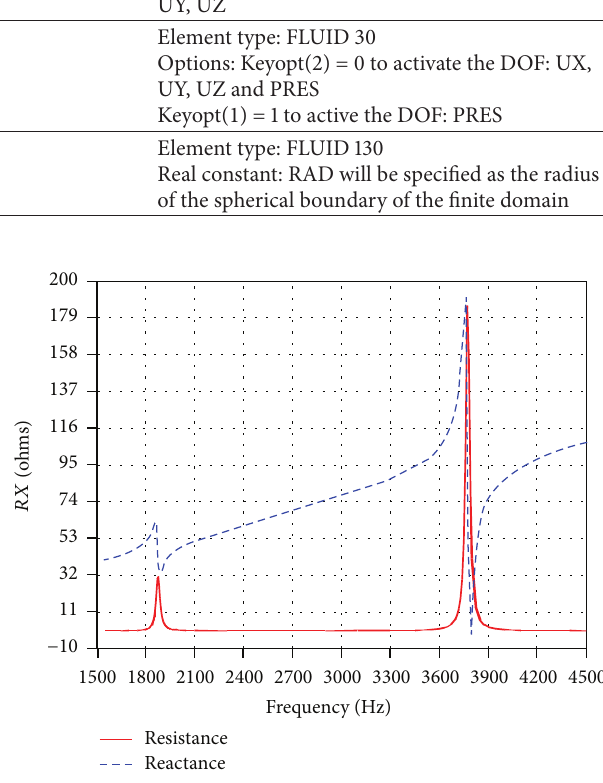
Figure 7: Impedance curves when only current drives in magne- tostrictive section (in water, obtained from finite element model).